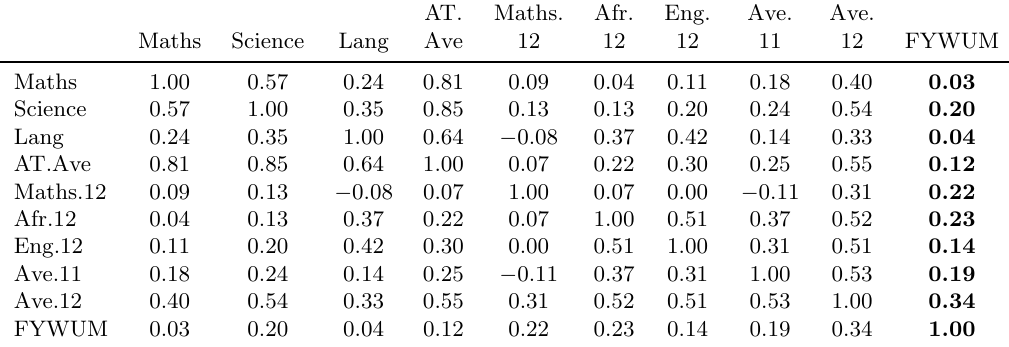
Table 10: Inter-correlations among the Test Battery 1 variables – 2000 [Critical r = 0 . 12 (5% significance level), 0.17 (1% significance